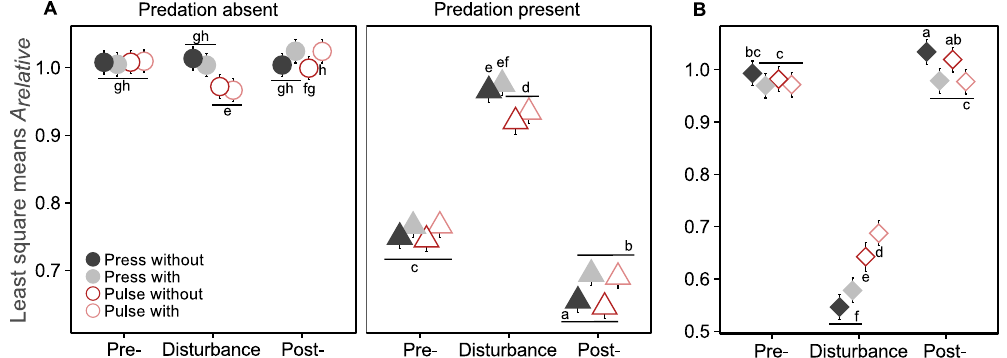
Figure 2. Magnitude of change in prey abundance relative to the control under the absence and presence of the predator and disturbance treatments ( A ), magnitude of change of predator abundance relative to the control under disturbance treatments ( B ). Colors code for the disturbance treatments; “press” and “pulse” are the disturbance types, “with” indicates that the disturbance is coupled with a resource deprivation and “without” is without resource deprivation. Points represent least square means for each treatment and the error bars are the confidence intervals. Bonferroni-Holm corrected multiple comparisons are shown as letters. Groups sharing the same letter are not statistically